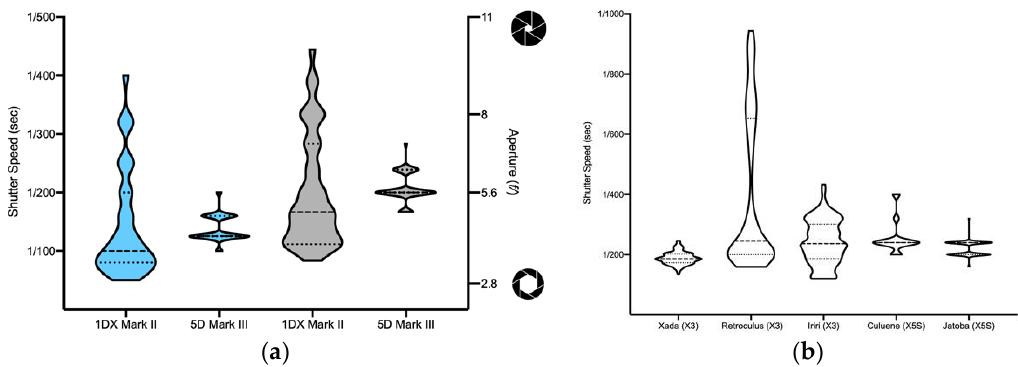
Figure 17. ( a ) Violin plots of the shutter speed (blue) and aperture (grey) used to take the photographs for calculating the within model uncertainty (Canon 1DX Mark II) (Figure A1) and for the stream survey (Canon 5D Mark III) (Figure 10). Focal length for both cameras was 24 mm. ( b ) Violin plots of the shutter speed from the UAV photographs from the five study sites (Figure 1).